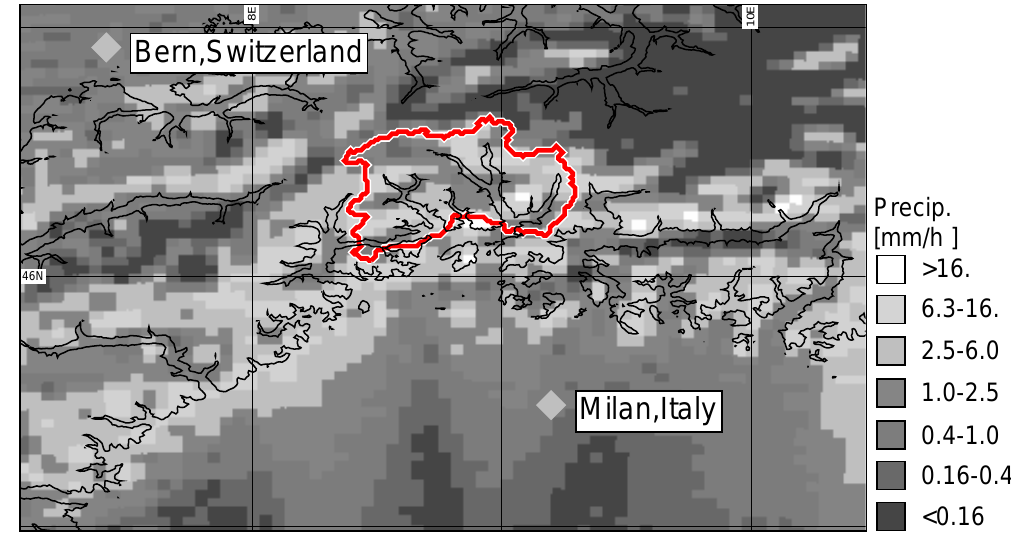
Fig. 11. Same as Fig. 10, but a precipitation field with grid spacing of about 4km simulated by ALADIN-nh is